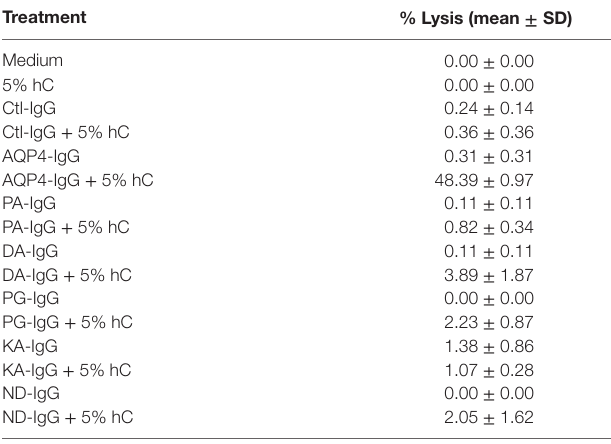
TaBle 1 | AQP4–IgG-mutated antibodies with limited complement-mediated cytotoxicity. Treatment